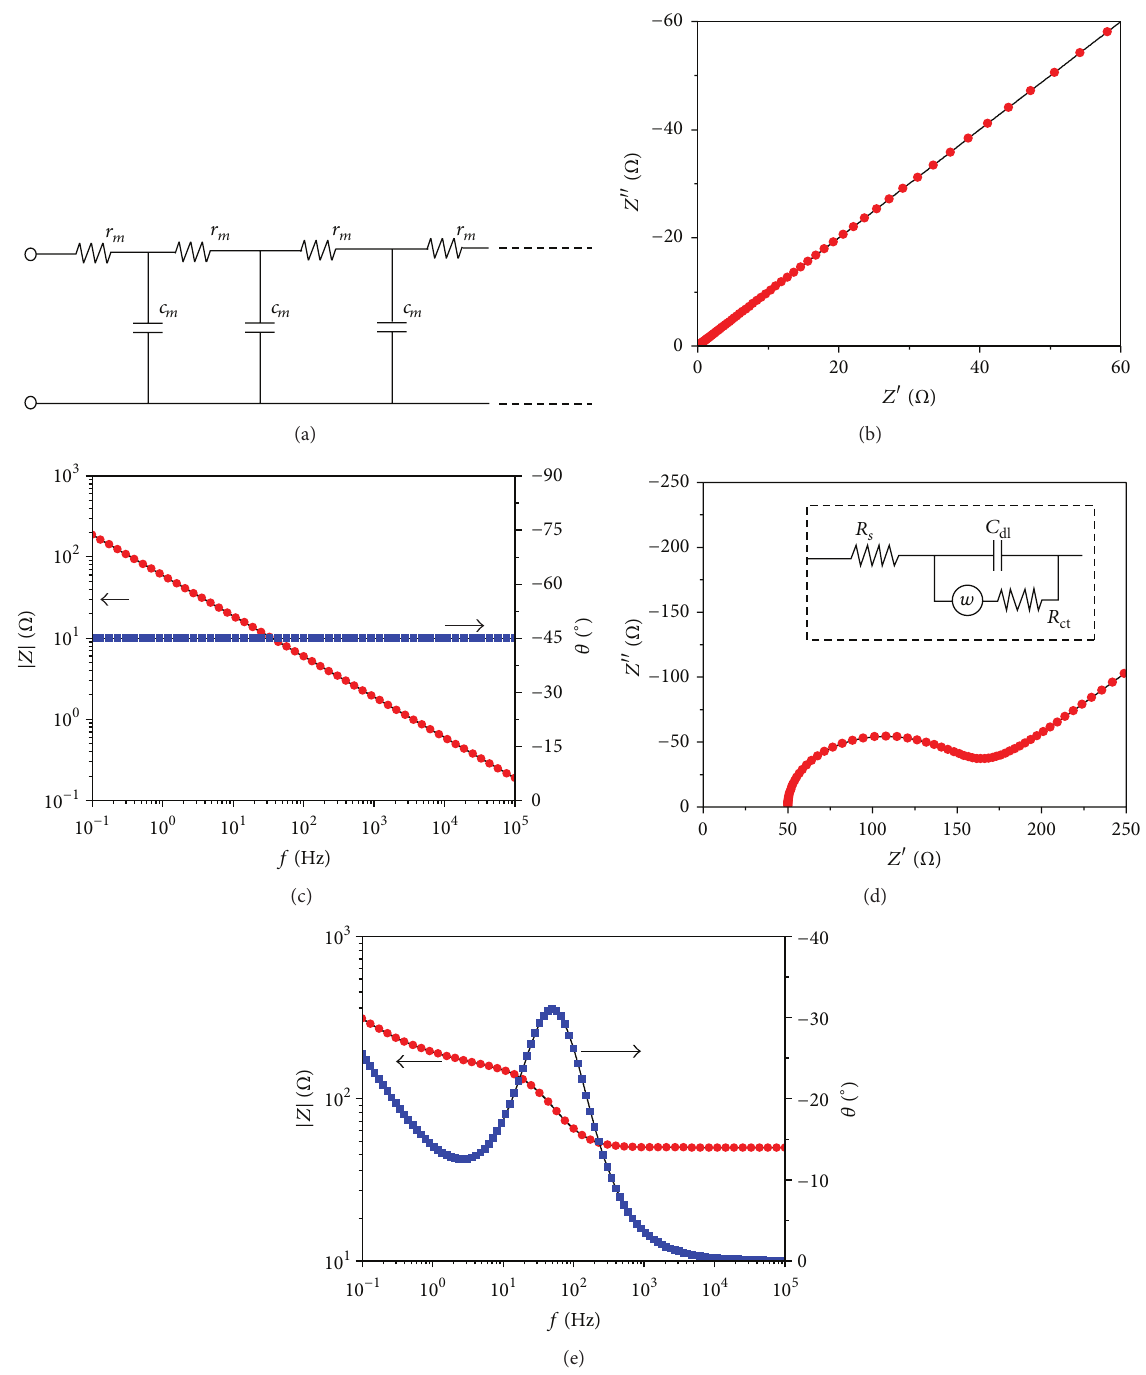
Figure7:(a)Semi-infinitetransmissionlinedepictingdiffusionprocess.(b)Complexplaneand(c)BodeplotfortheWarburgdiffusionwhere the coefficient 𝜎 = 150 Ω s −0.5 . (d) Complex plane and (e) Bode plot for the impedance corresponding to Randle’s circuit with 𝑅 𝑠 = 50 Ω , = 100 Ω , and 𝐶 = 100 𝜇 F and the Warburg coefficient 𝜎 = 150 Ω s −0.5 . Inset (d) shows Randle’s circuit and magnitude and phase plot for 𝑅 ct dl Randle’s